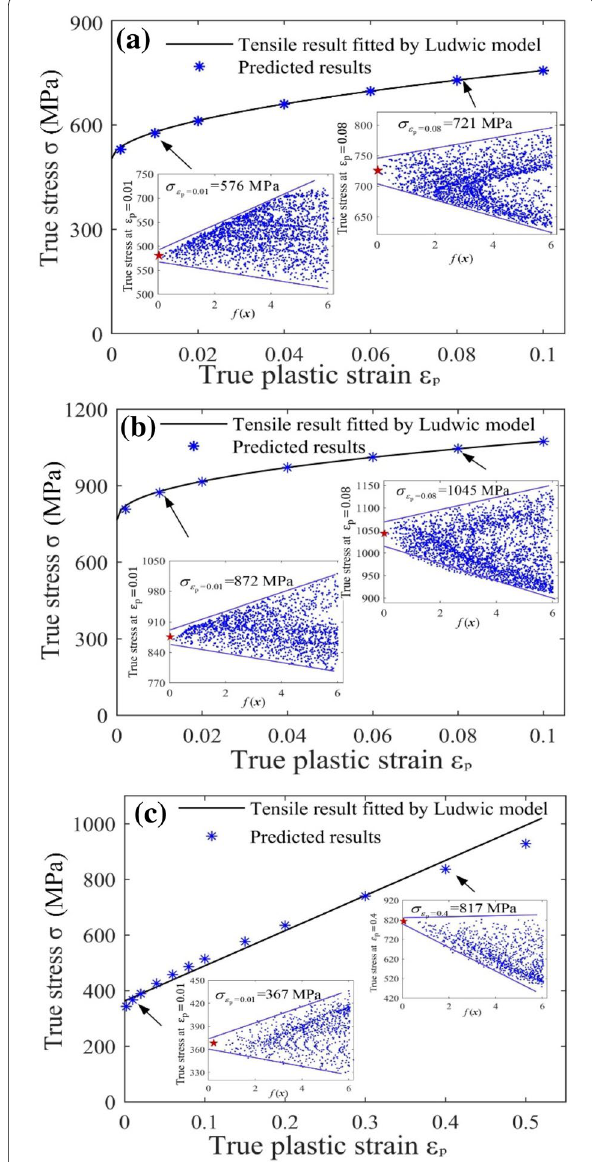
Figure 7 Flow curves fitted from experimental tensile results and predicted using database method with simulated indentation data as inputs for ( a ) A508, ( b ) 2.25Cr1Mo and ( c )